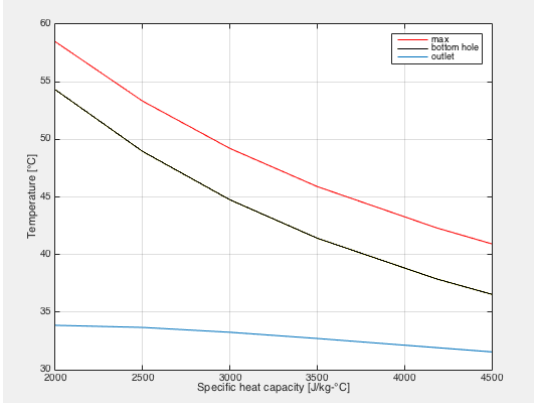
Figure 5: Temperature distribution( c p = 3000 J/kg ◦ C)